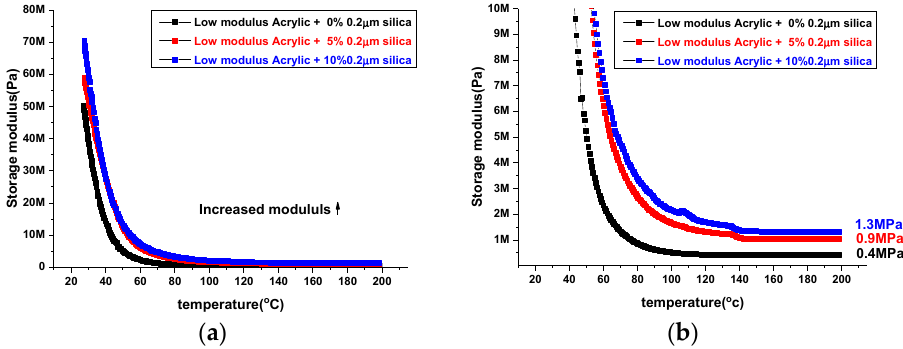
Figure 24. Elastic modulus of acrylic based SnBi58 solder ACFs by adding 0, 5, and 10 wt % 0.2 μ m silica fillers at ( a ) 0–80 MPa and ( b ) 0–10 MPa ranges.